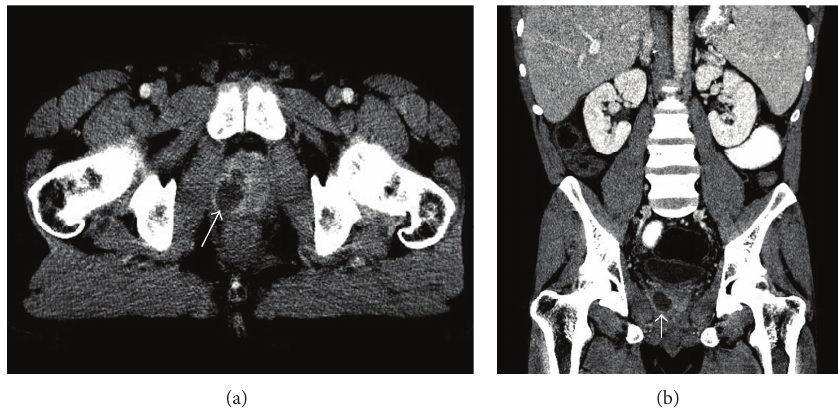
Figure 1: Axial (a) and coronal (b) views of CT abdomen and pelvis revealing a 3.0 cm × 1.9 cm prostatic abscess (arrow).